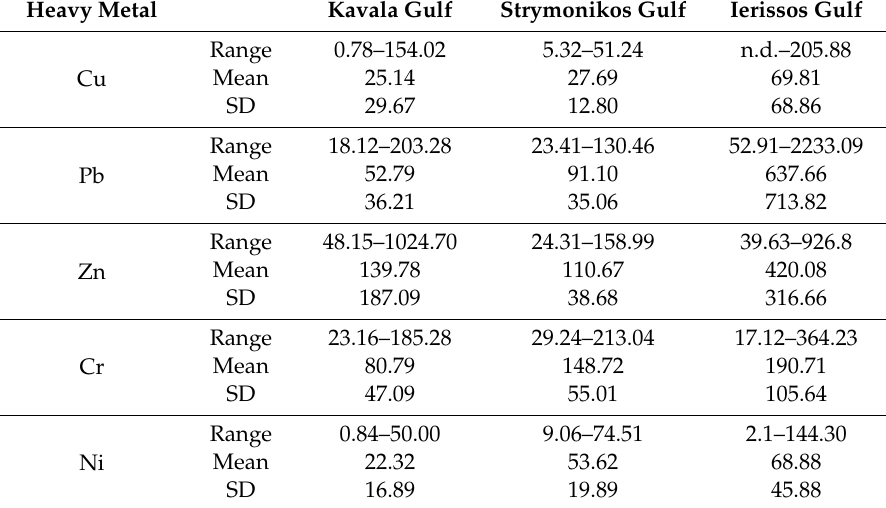
Table 2. Range, mean concentrations and standard deviation of heavy metals observed at Kavala, Strymonikos and Ierissos Gulfs (n.d. = not detected; SD = Standard Deviation).